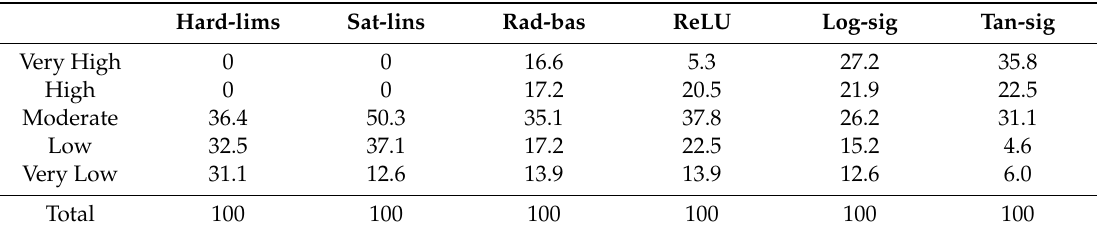
Table 6. Comparison of the six landslide susceptibility models using the Friedman test. Ranking p-value Hard-lims Sat-lins